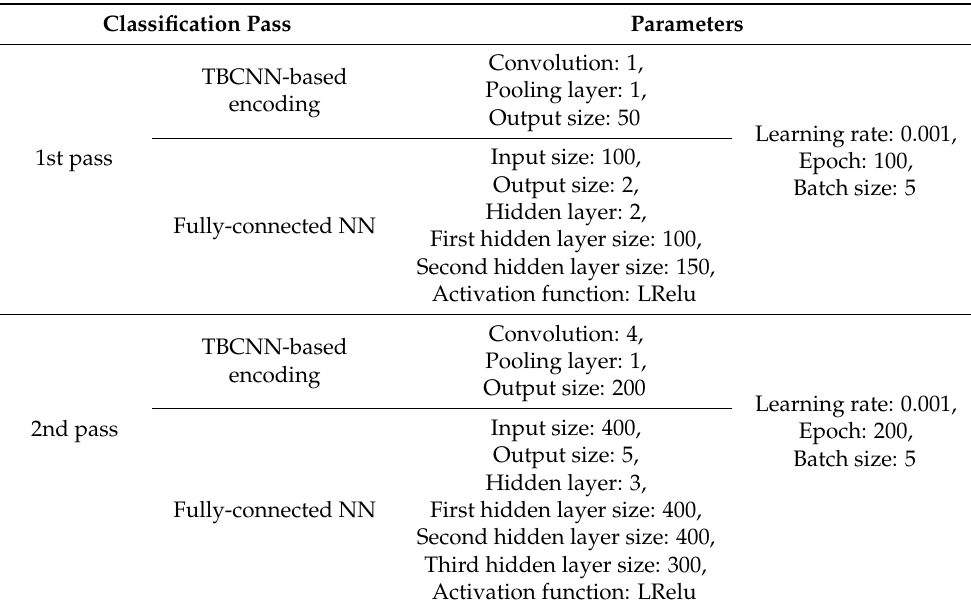
Table 3. Parameter settings for each classification